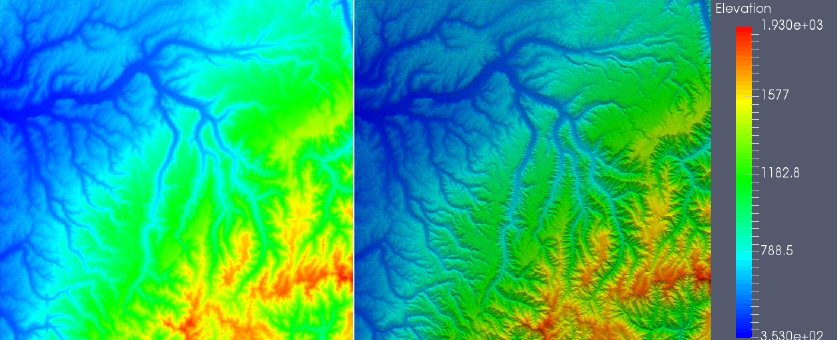
Figure 11. Experimental site 2: UTM11 Zone. Left: image view. Middle: hillshade view. It is a 3875 × 3758 grid with a 10m cell size. Table 1. Quantitative comparison of the grid quality at scale-transformation ratio 1%. Dataset Dense DEM Random inter- Approx. Mean Max RMSE Max aspect points polation points method error (m) error (m) (m) ratio St. Helen 3m 11386056 230909 cCVT 0.0353 23.05 1.6145 3.23 HFPR 0.1107 191.31 2.3714 9255 UTM11 10m 14562250 301255 cCVT 0.5773 37.70 3.77313 HFPR 487.81 6.71214 8426